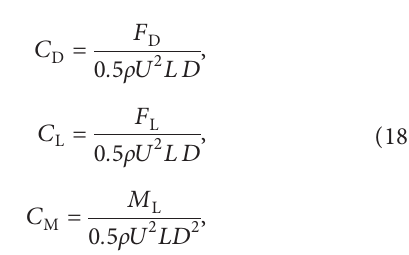
Figure 6: Aerodynamic coefficients under various wind velocities. (a) Aerodynamic coefficients of subconductor 1. (b) Aerodynamic coefficients of conductor 2. (c) Aerodynamic coefficients of subconductor 3. (d) Aerodynamic coefficients of subconductor